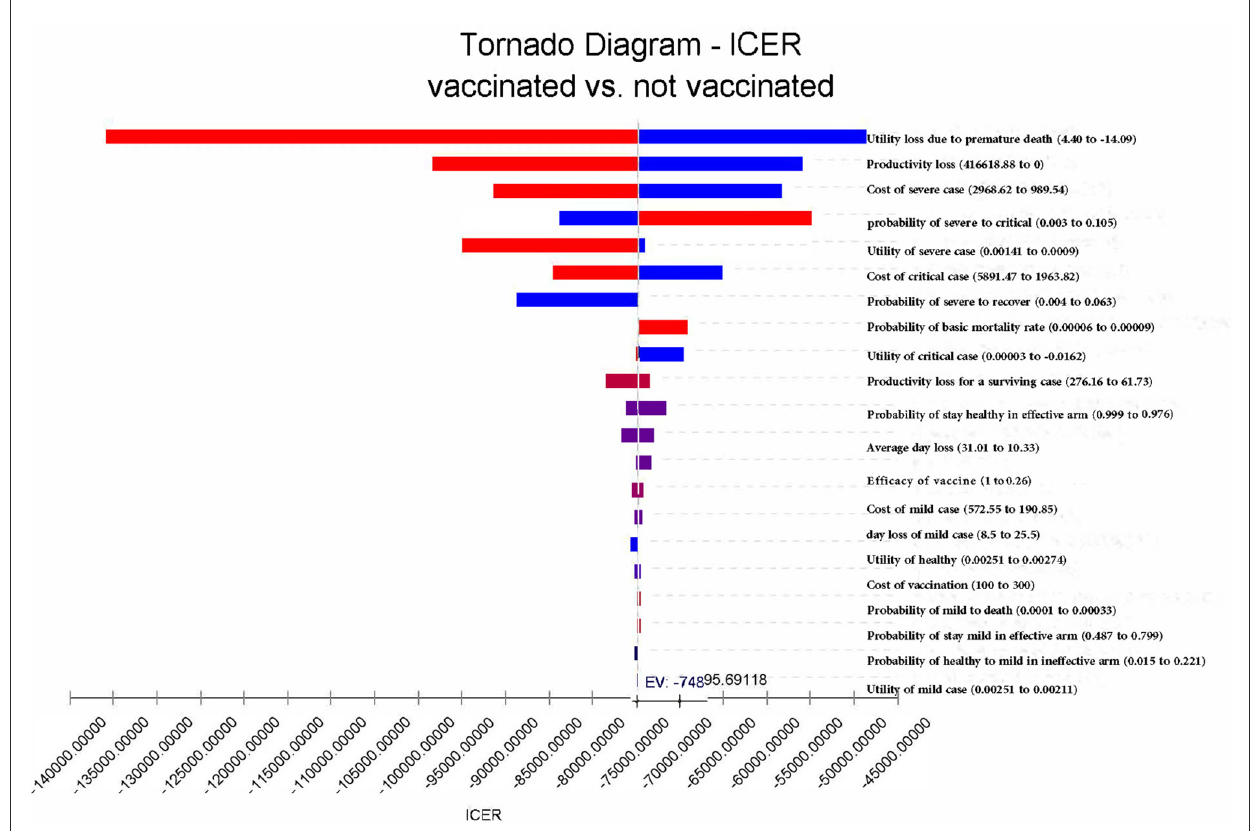
FIGURE6 One-way sensitivity analyses for ICER of “vaccinated” vs. “not